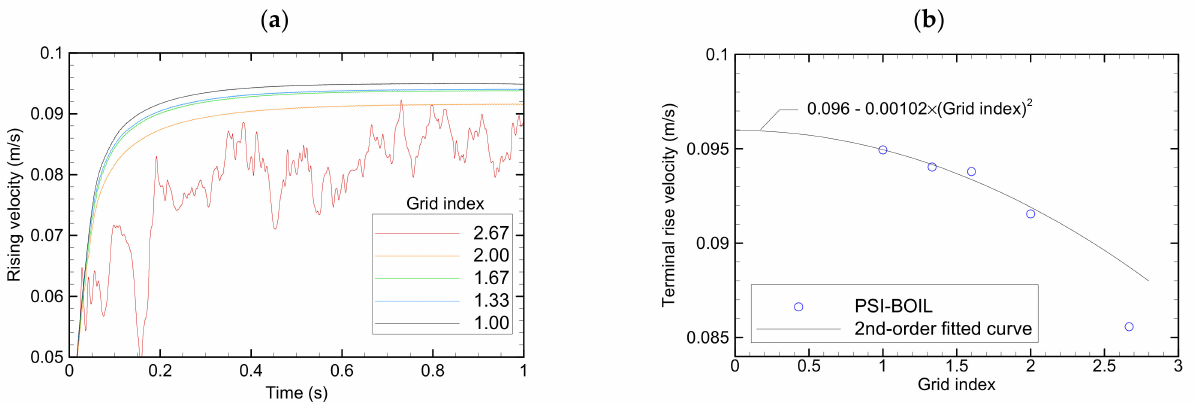
Figure 9. Grid dependency study for Case G-B2: ( a ) time evolution of bubble rise velocity, ( b ) terminal rise velocity as a function of Grid index . The terminal rise velocity converges at 2nd-order accuracy.